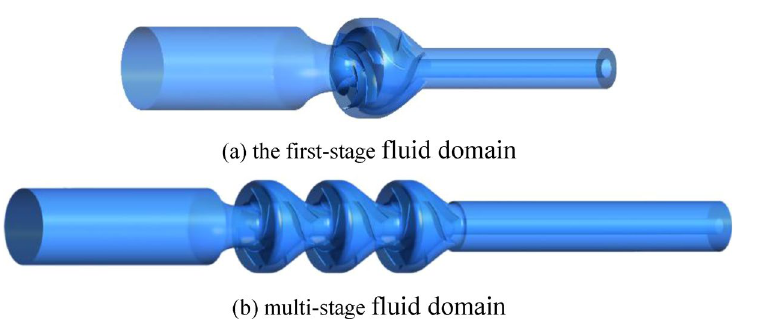
Figure 2. Three-dimensional fluid domains of the